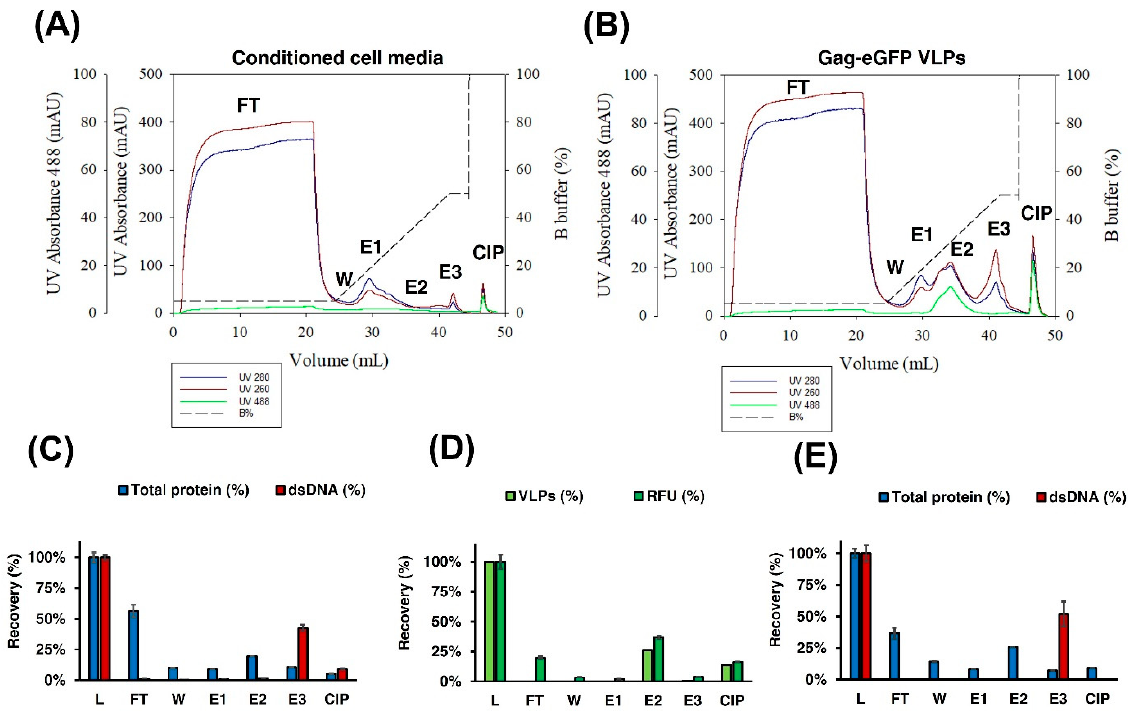
Figure 3. IEX chromatography purification of Gag-eGFP VLPs. ( A , B ) Chromatogram of the linear-gradient purification of conditioned medium or Gag-eGFP VLP supernatant using a Mustang ® QXT, respectively. The recovery of VLP nanoparticle concentration measured by flow virometry (VLPs) and relative fluorescent units (RFU) ( D ) and total protein and dsDNA content in the conditioned cell culture medium run ( C ) and in the Gag-eGFP VLP run ( E ) were also assessed. L: load material; FT: flowthrough; W: wash; E1-E3: pooled fractions for peaks 1–3 and CIP: cleaning in place with 2 M NaCl.